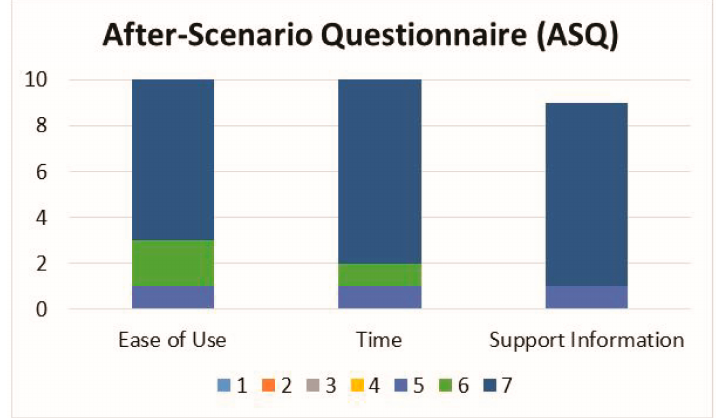
Figure 5. Frequency bar graph of the ASQ survey results.